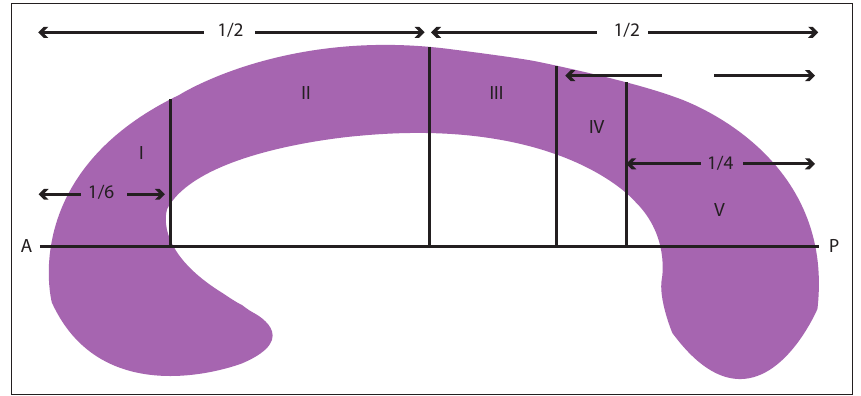
Fig. 1. Scheme, modified from Hofer and Frahm: [27] region I: prefrontal; region II: premotor and supplementary motor; region III: motor; region IV: sensory; region V: parietal, temporal and occipital fibres. (A = anterior; P = posterior.)